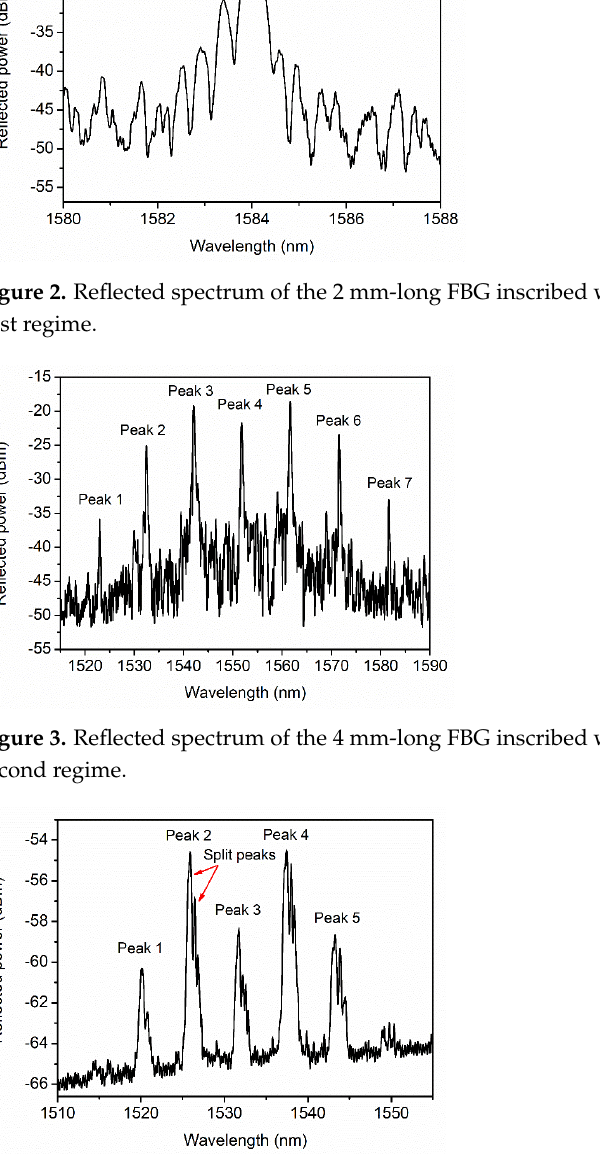
Figure 4. Reflected spectrum of the 4 mm-long FBG inscribed with a pulse energy of 13.54 nJ in the second regime.